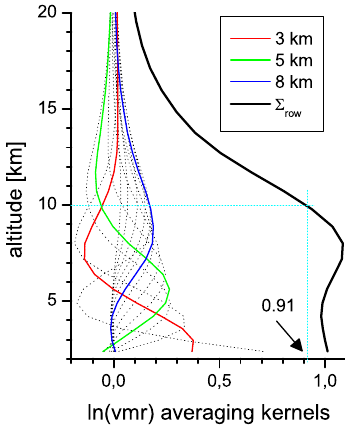
Fig. 8. Typical averaging kernels for ground-based FTIR remote sensing of water vapour. The kernels for 3, 5, and 8km are high- lighted in red, green, and blue, respectively. The sensitivity ( P row ) is depicted as a thick black